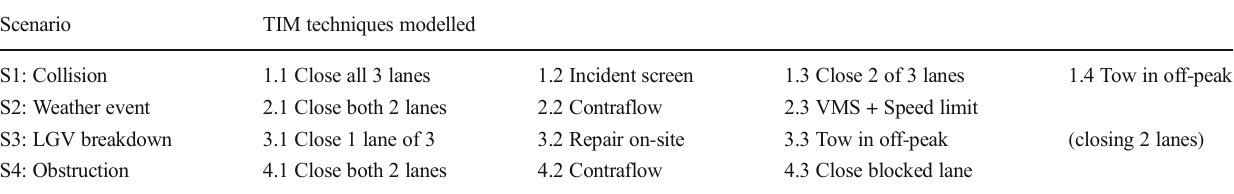
Overview of modelled incident scenarios and techniques Scenario TIM techniques